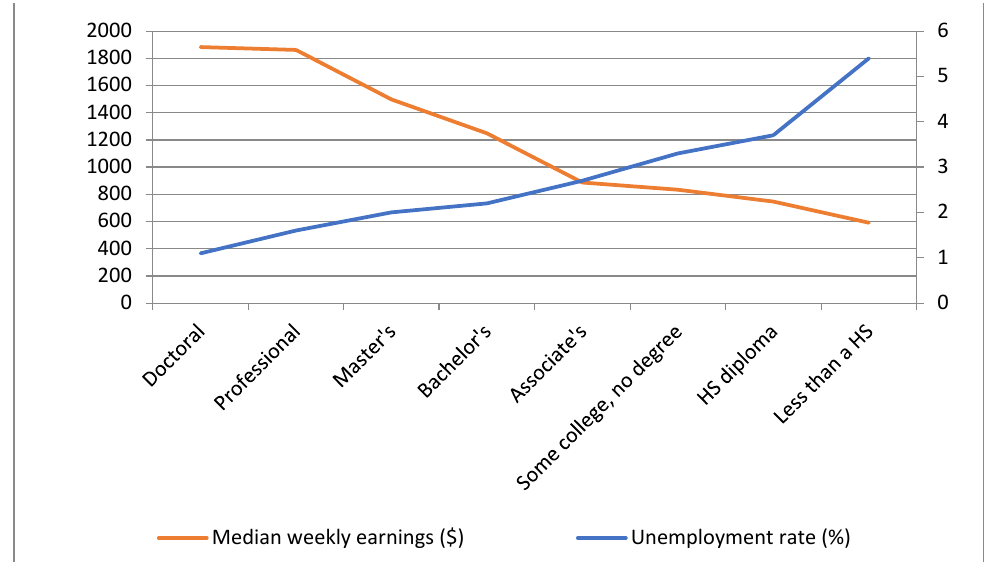
Figure 2. Unemployment Rate (%) and Median Weekly Earnings (USD) by Educational Attainment. Source: U.S. Bureau of Labor Statistics. Note: Data updated in September 2020.